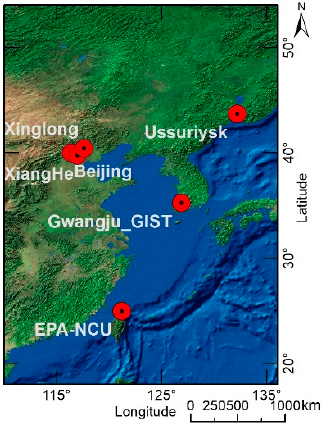
Figure 1. Overview of the study area and the AERONET stations.